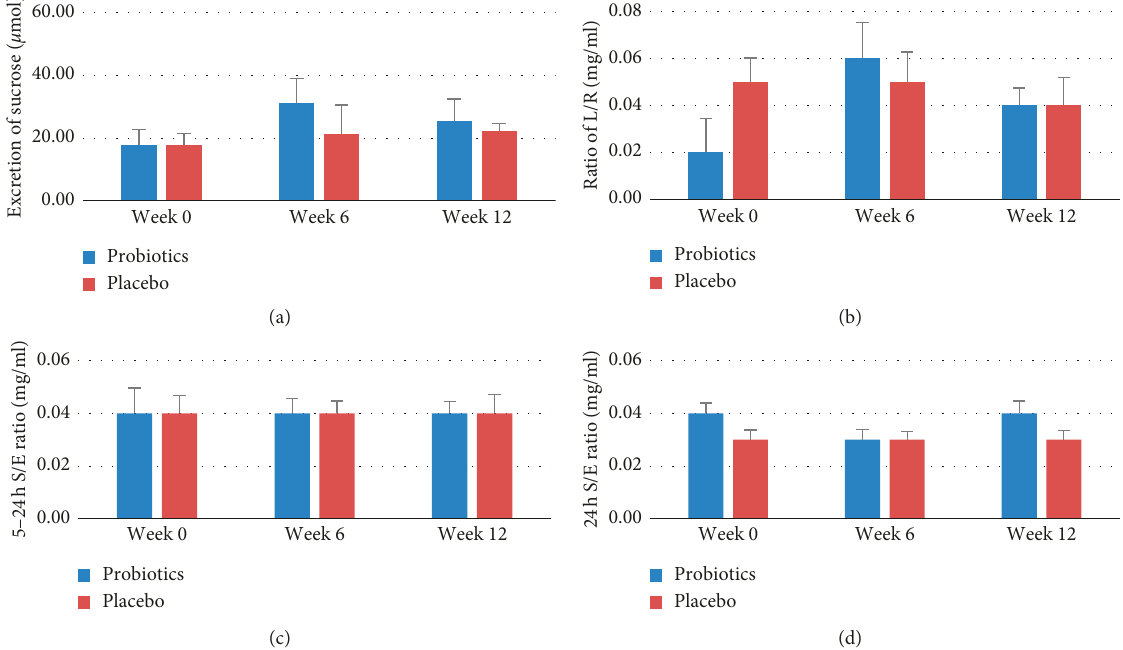
Figure 2: Results of the 5-sugar test with L/R, lactulose/rhamnose ratio, and S/E, sucralose/erythritol ratio. (a) Excretion of sucrose in μ mol; (b) L/R ratio; (c) 5–24 h S/E ratio; (d) 24h S/E ratio. No significant differences between time periods or between groups were found. Values are means ±